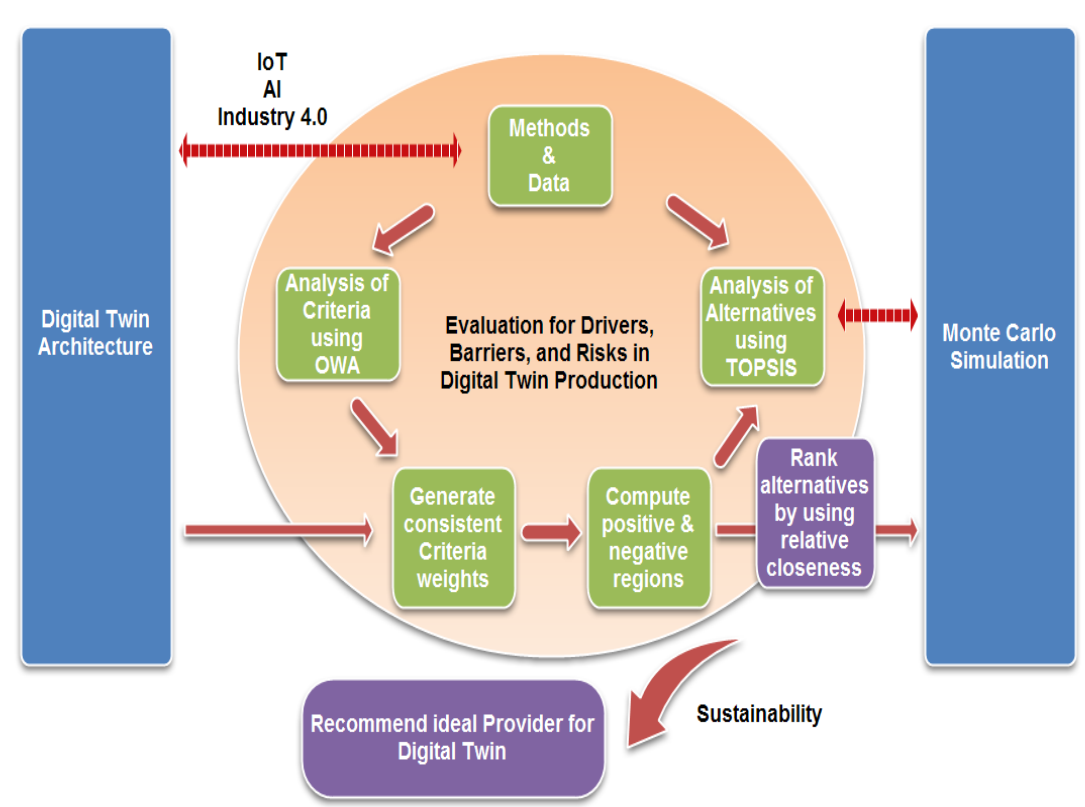
Figure 1. The model for ranking drivers, barriers, and risks for DT.